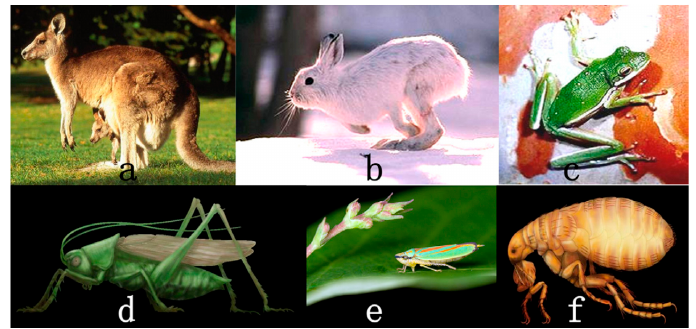
Figure 3. Jumping animals ranging with body size [38]: ( a ) kangaroo; ( b ) rabbit; ( c ) frog; ( d ) cricket; ( e ) leafhopper; ( f ) flea.